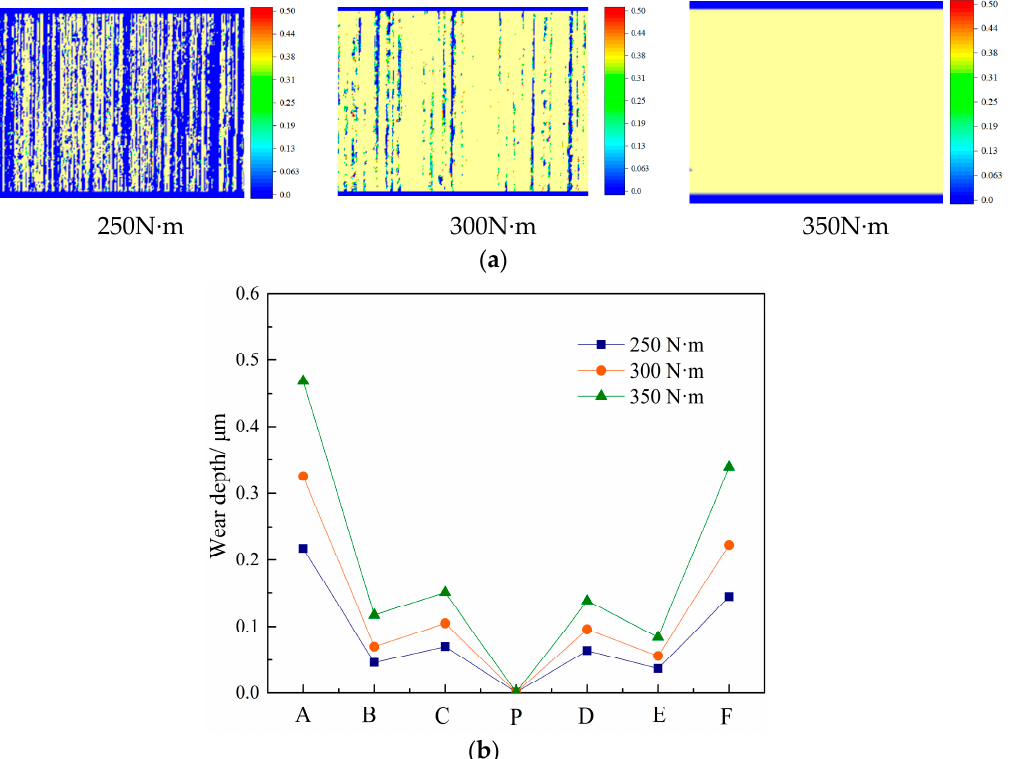
Figure 17. Wear degree at different torques. ( a ) Wear distribution. ( b ) Wear depth.